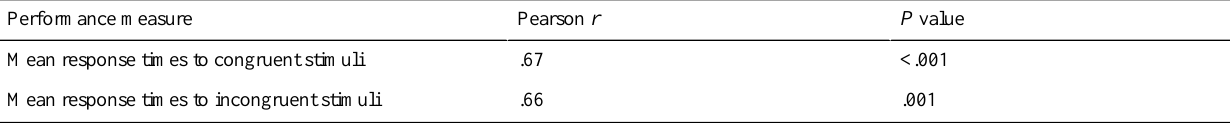
Table 4. Correlation analysis between performance measures in the Color test and the Stroop color-word test.